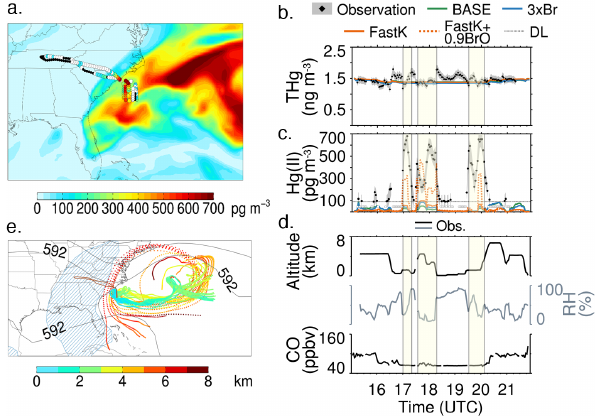
Figure 8. Case study for RF-16 on 8 July 2013. Same as Fig. 6, except the background map (a) displays Hg(II) concentrations at 800hPa for the FastK + 0 . 9BrOpptv simulation. Also we add the FastK + 0.9ppt simulation as an orange dashed line in panels (b, c) . O 3 concentrations were not available for this flight and BrO concen- trations were below the instrument’s detection